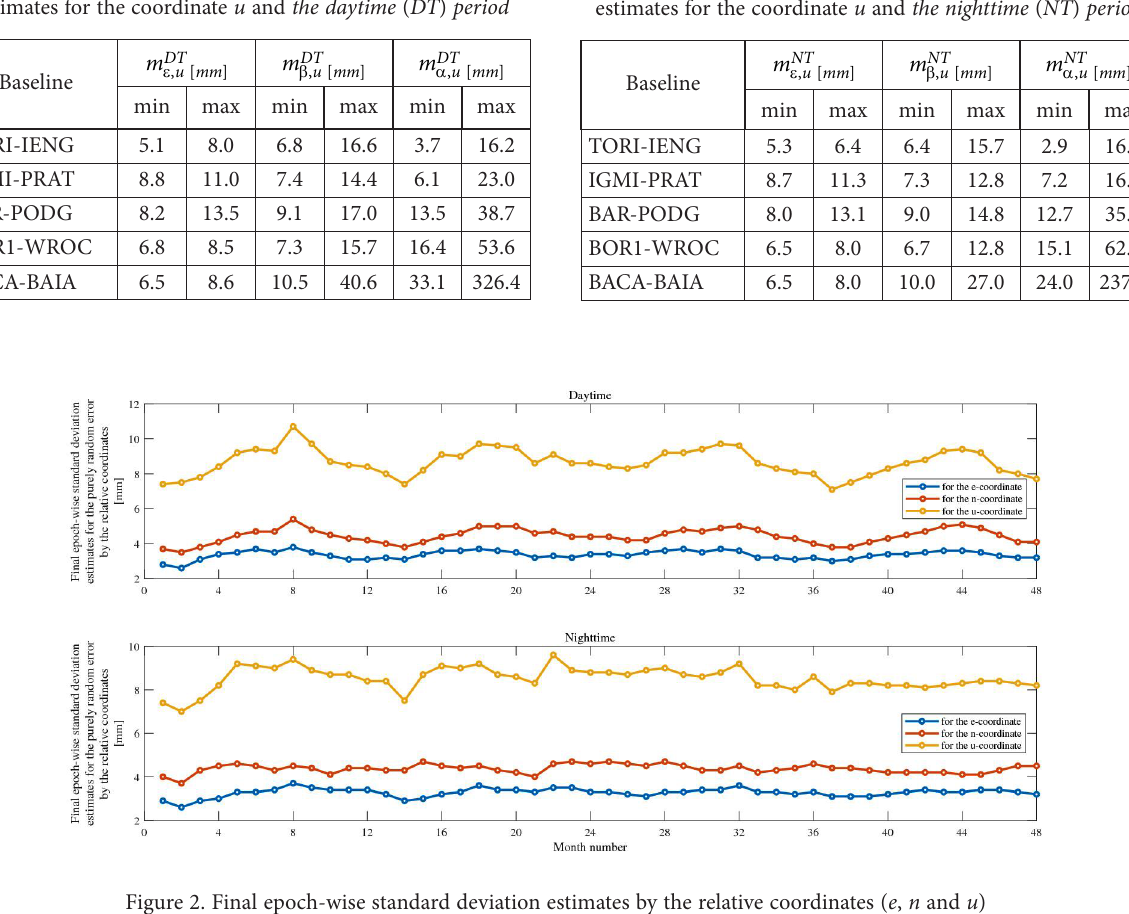
Table 6. Extreme values of epoch-wise standard deviations